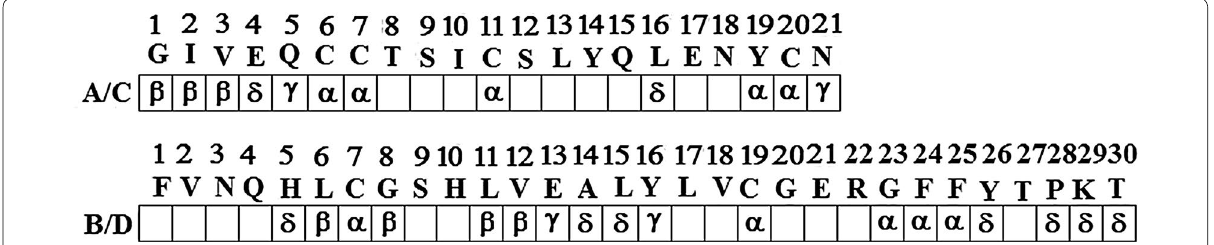
Fig. 2 Analysis of residues in the porcine insulin structure of Baker et al. [1] which may be important factors involved in the biological activity. α indicates most likely and γ is least likely to be active. The positionally invariable cysteines that form the disulphide bridges are also included as being very likely to be involved, rated